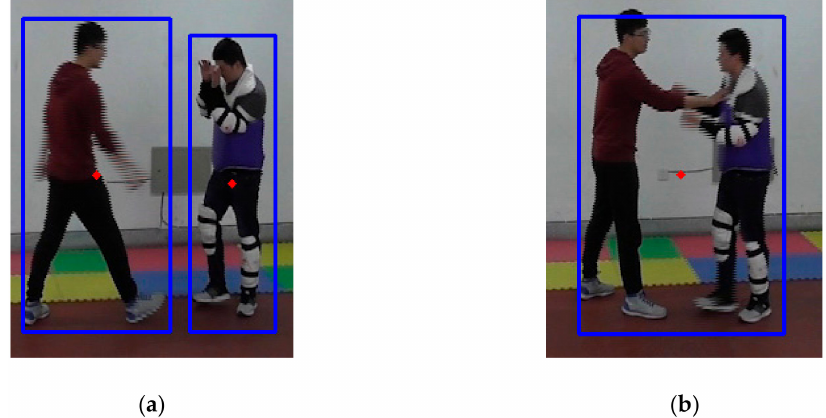
Figure 7. Images after circumscribed rectangular frame integration: ( a ) fixed Figure 4a and ( b ) fixed Figure